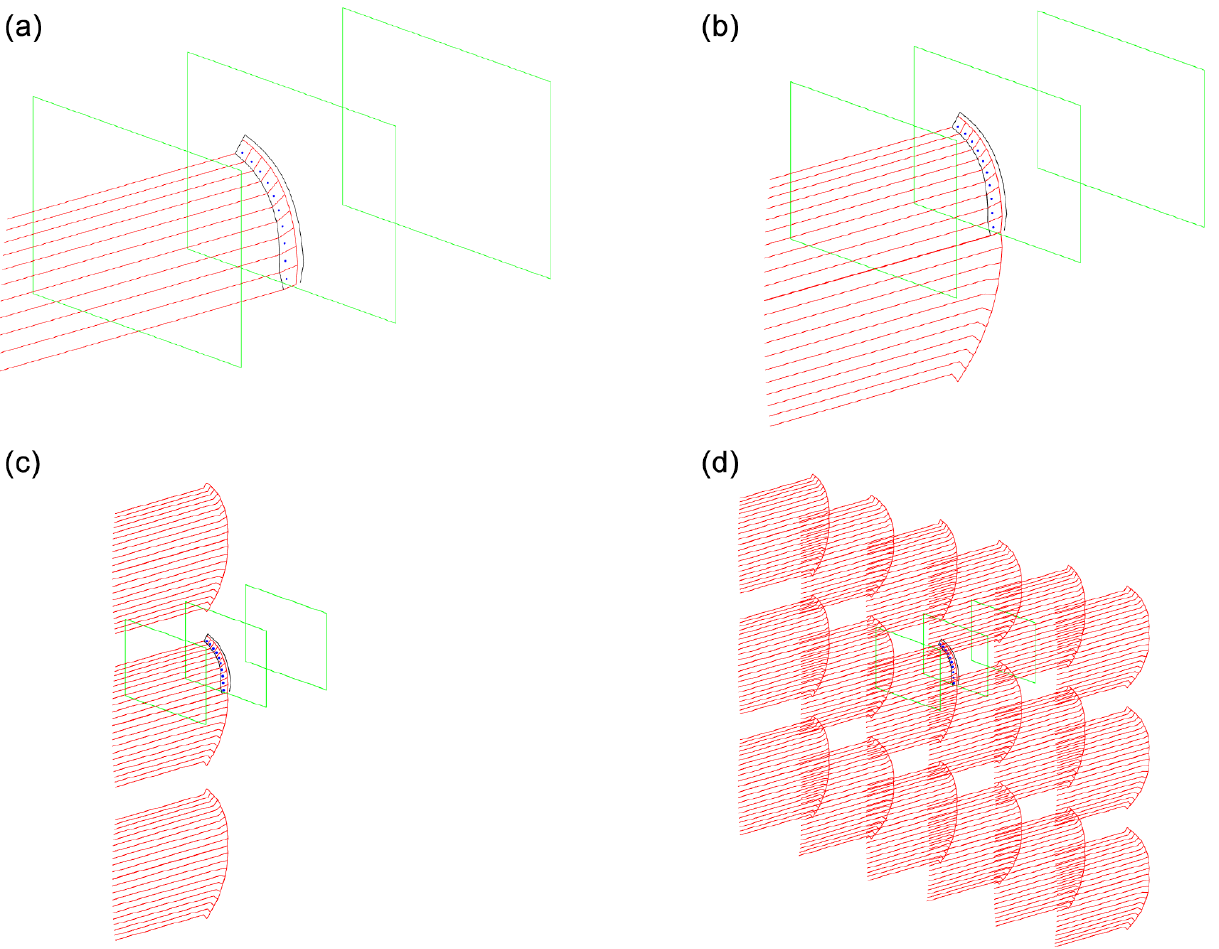
Figure 8. Illustration of the use of mirror image model walls. (a) Vortex system of physical wing only. The tunnel is outlined in green. (b) Vortex system of physical wing and mounting wall vortex systems. This corresponds to what is modeled in all other codes. (c) Vortex system of the nearest mirror images from two parallel walls. (d) Vortex system from the nearest mirror images due to all four tunnel